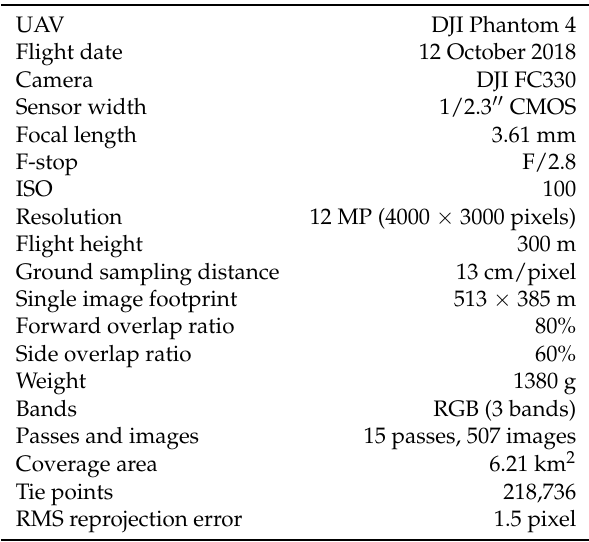
Table 2. Characteristics of the UAV acquisition of the Podor depression in the Senegal